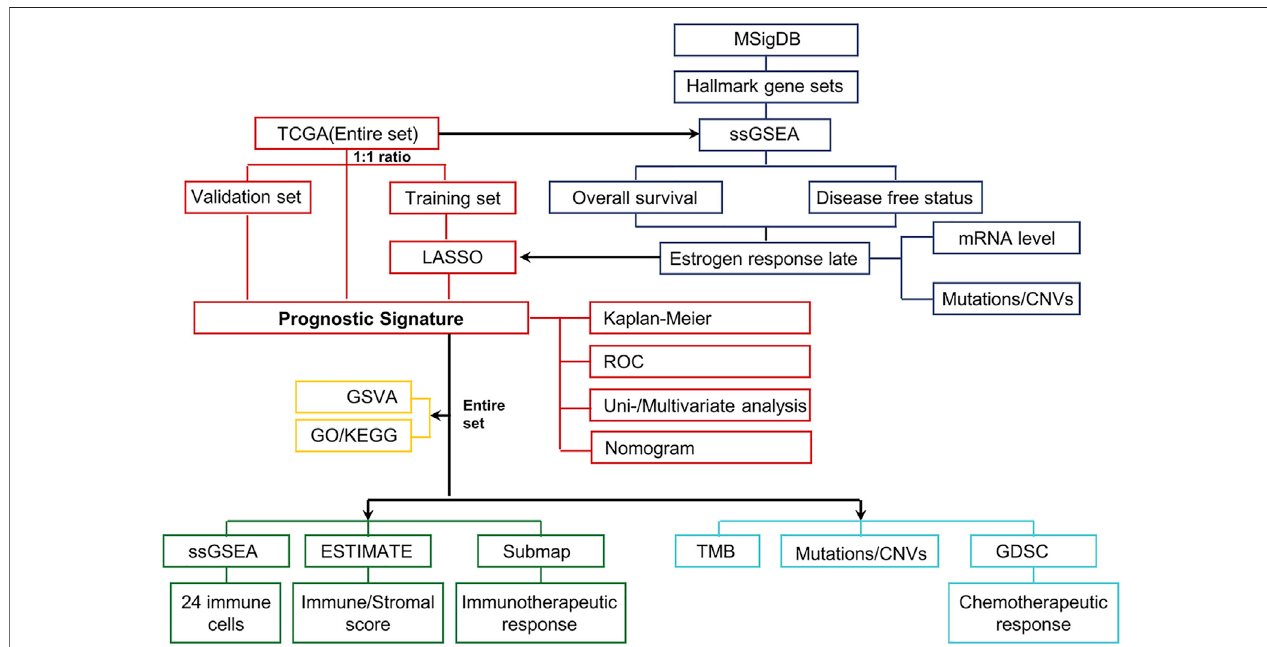
FIGURE 1 | Schematic work fl ow for establishing the estrogen-response-related risk model and a multidimensional evaluation of patients in different risk groups. First, the transcriptome data and the corresponding clinical characteristics data of UCEC were downloaded from the UCSC Xena browser and cBioPortal. These tumor samples (the Entire set) were then randomly classi fi ed into the Training set ( n = 268) and the Validation set ( n = 267). The ssGSEA scores of various hallmarks were calculated based on the transcriptome pro fi ling of the Entire set and gene sets of MSigDB using ssGSEA. We identi fi ed that the “ Estrogen response late ” ssGSEA scorewasthemostsigni fi cantprotectivefactorforOSandDFSinUCEC.Subsequently,theLASSOCoxanalysismodelwasusedtoidentifyandconstructaprognostic gene signature in the Training set, further veri fi ed in the Validation set and Entire set. Next, UCEC patients from the TCGA dataset were divided into low- and high-risk groupsaccordingtothemedianriskscore.TheKaplan – Meiercurves,ROCcurves,univariateandmultivariateCoxregression,andnomogramwereperformedtoidentify the independent predictors ofOS. To elucidate differencesin biological characteristics between the two risk groups, pathway enrichment, immunelandscape, genomic alterations, and therapeutic responses were evaluated to satisfy this